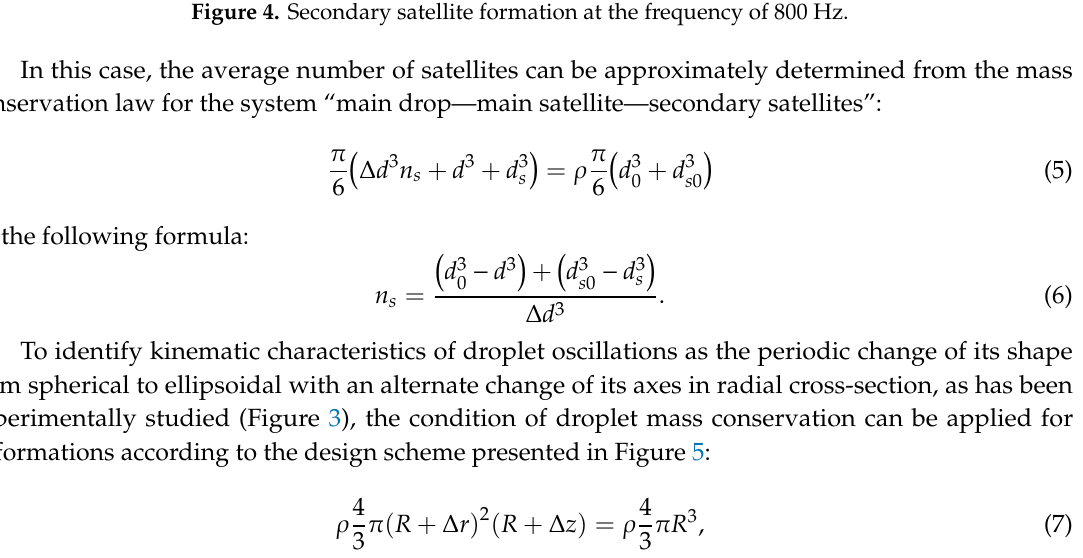
Figure 4. Secondary satellite formation at the frequency of 800 Hz.